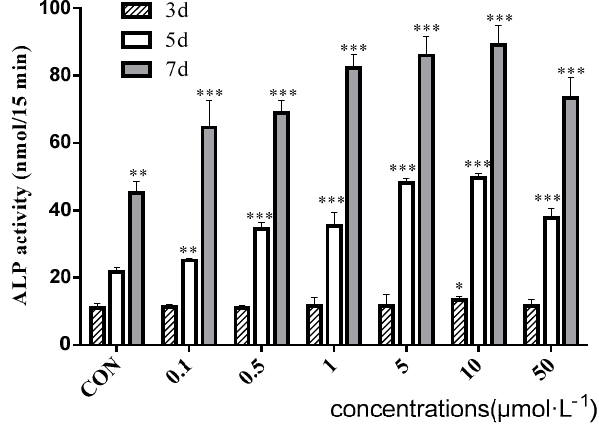
Figure 5. Effect of baicalin on ALP activity at various concentrations ( n = 6). * p < 0.05, ** p < 0.01, *** p < 0.001.